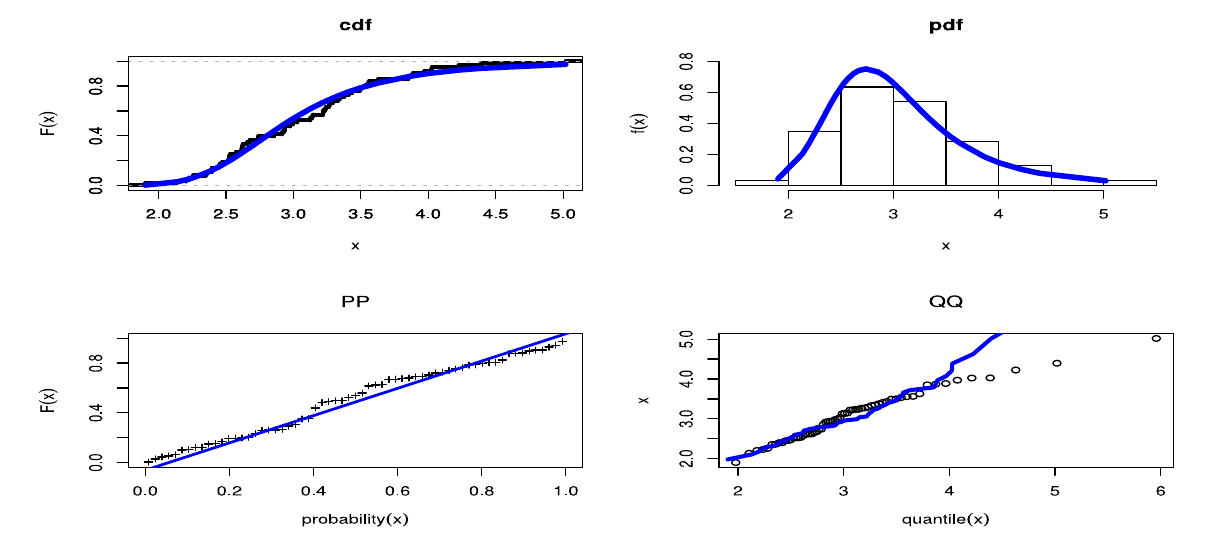
Figure 4. Fitting plot of APIW distribution of single carbon fibers.